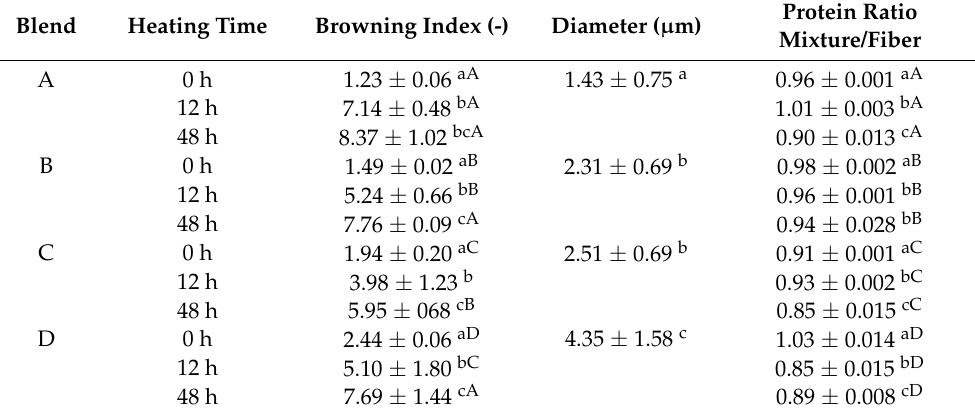
Protein Ratio Mixture/Fiber